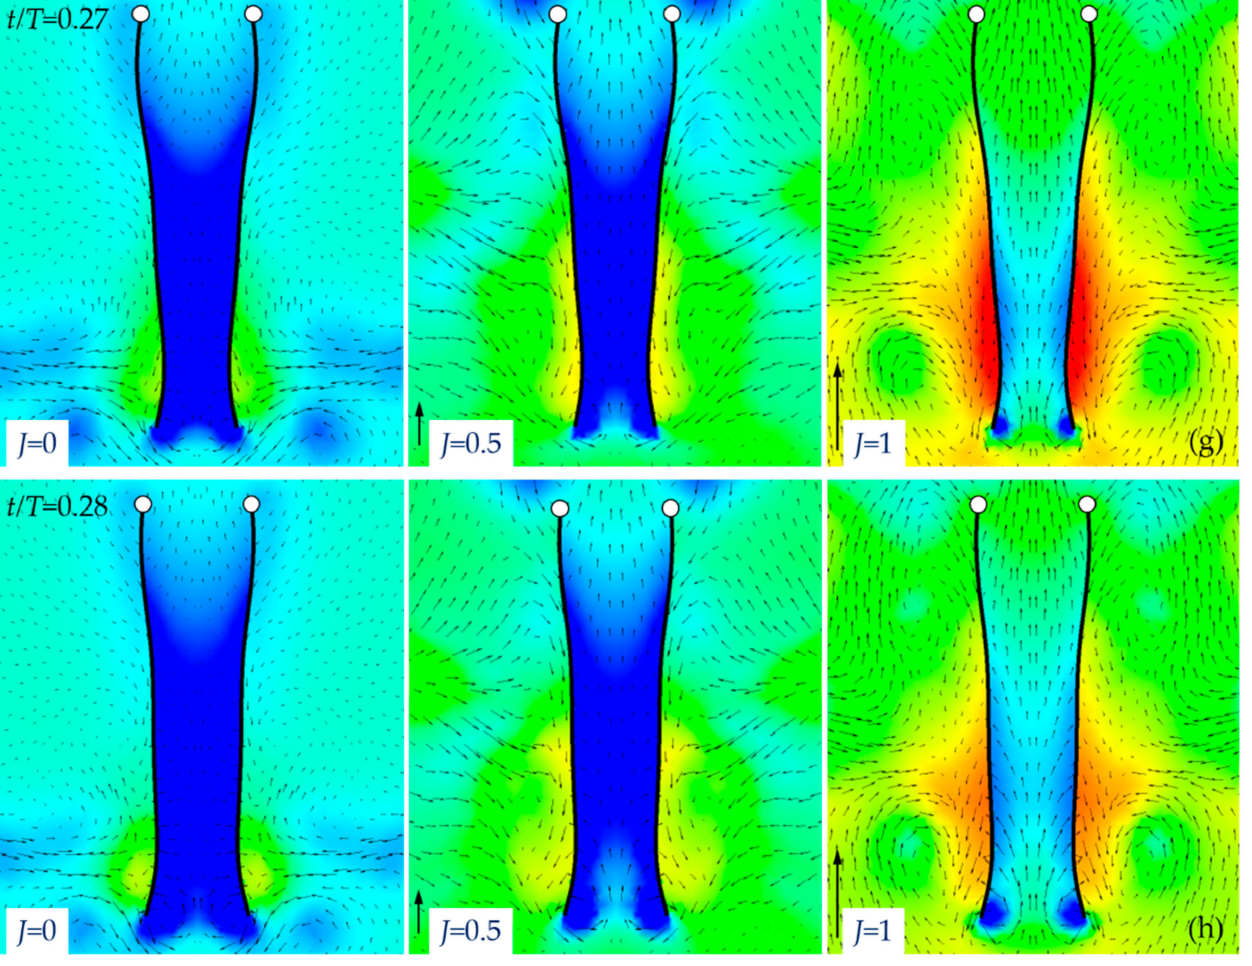
Figure 22. Flow fields in 25% c m -plane during down-stroke reversal; ( a – d ) Down-stroke clap; ( e – h ) Up-stroke fling. For all values of J , the wing distance is 16 mm. The black curves are the intersections between the wings and 25% c m -plane. The wing roots are marked with white